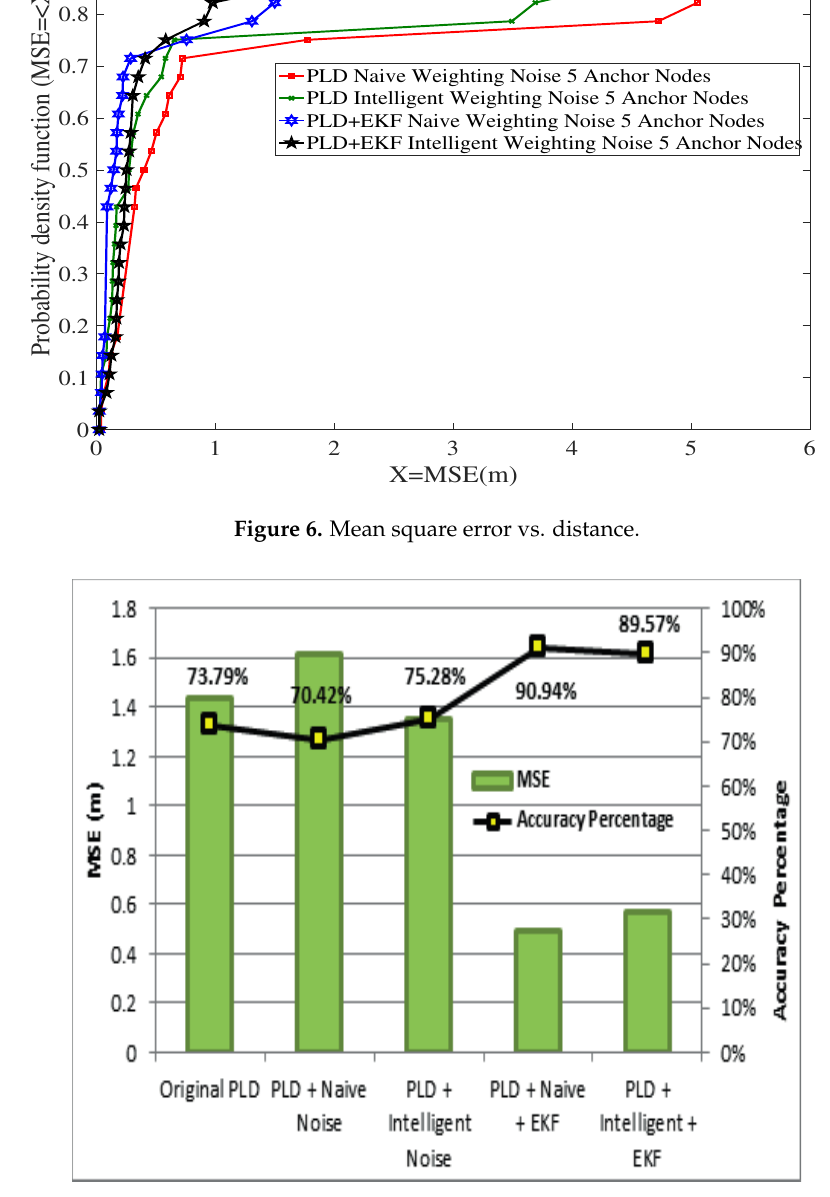
Figure 7. PLD performance in presence of naive, intelligent